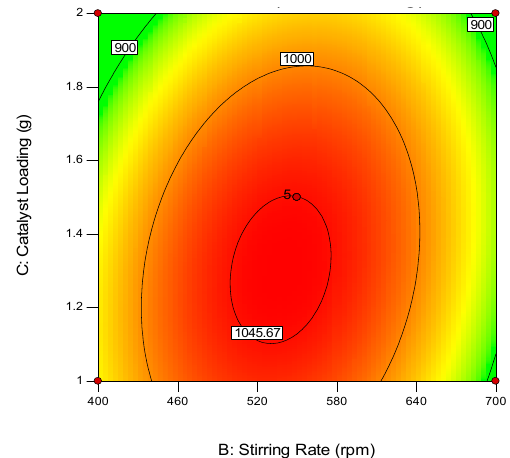
Figure 15. 2D contour diagram for representing methanol yield based on stirring rate and catalyst loading .